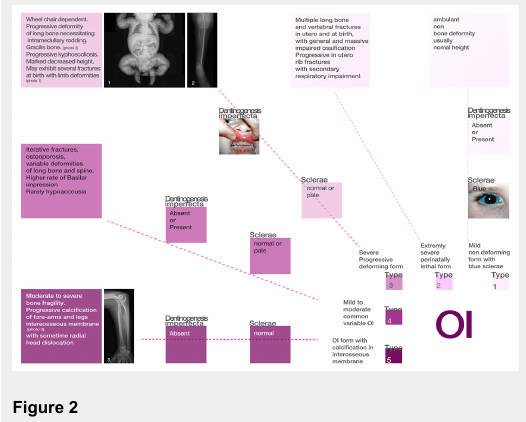
Characteristics of osteogenesis imperfecta (OI) types 1–5, illustrating morphological features for each